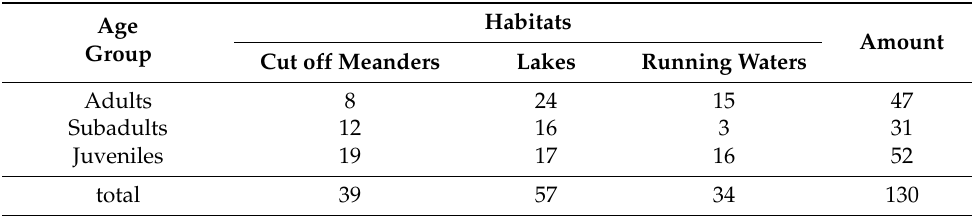
Table 1. Age groups and habitats of